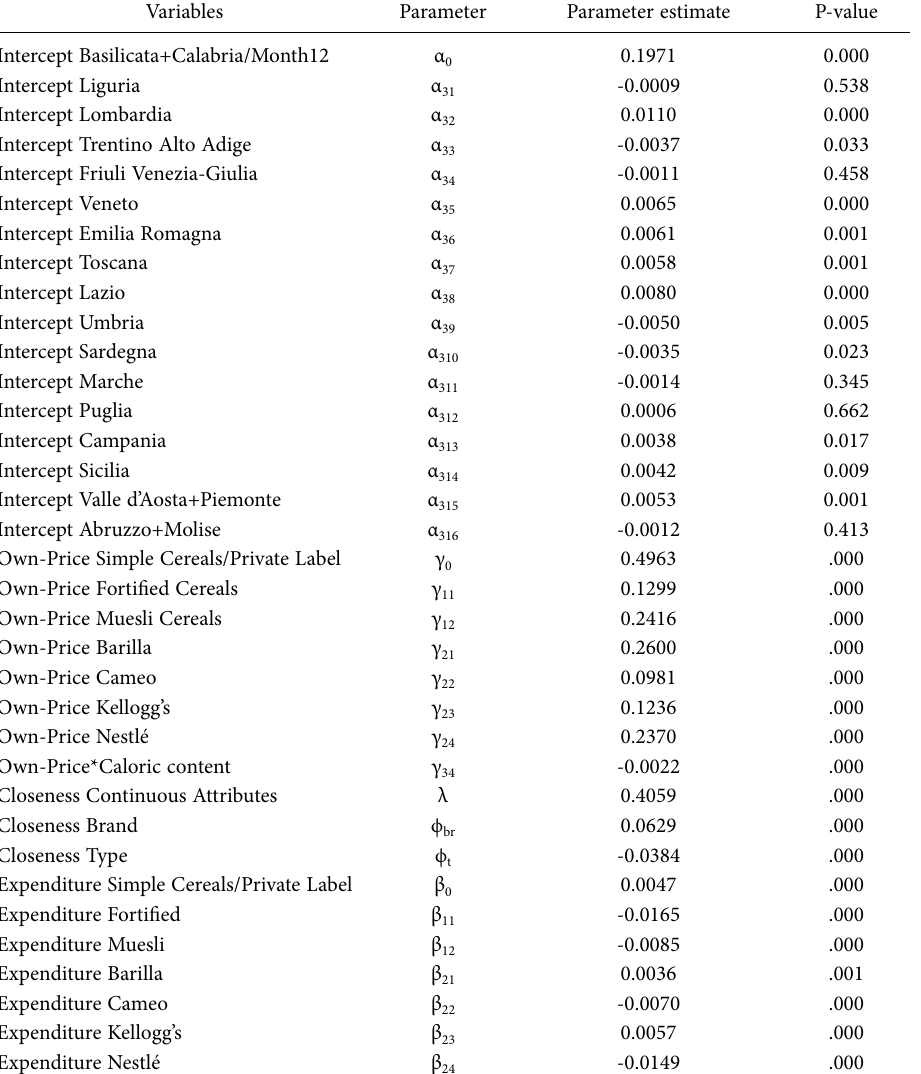
Table 2. Least squares estimated